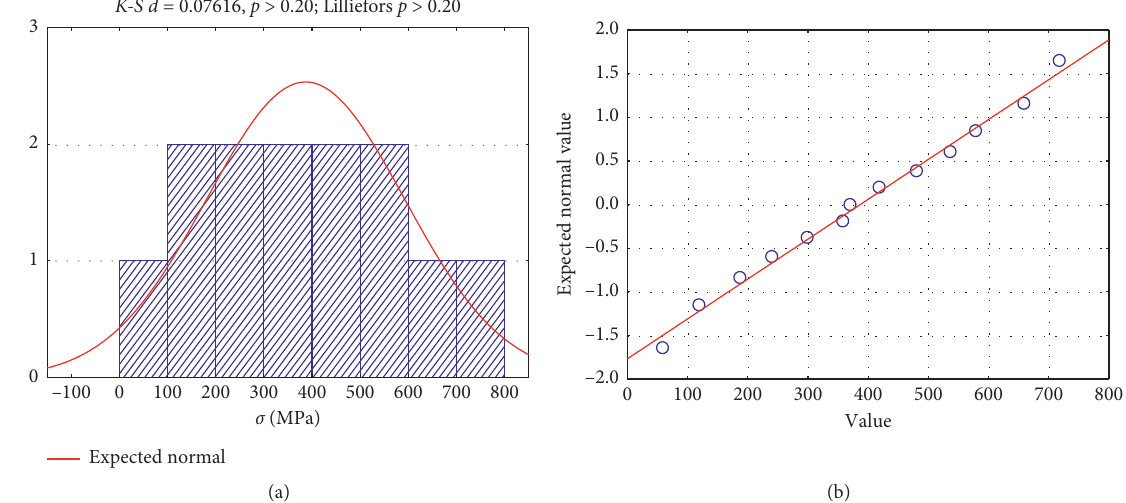
Figure 6: The distribution histogram of the stress experimental values with the superimposed curve of the expected normal distribution (a) and the graph of the normal distribution (b) for the deposited samples in group